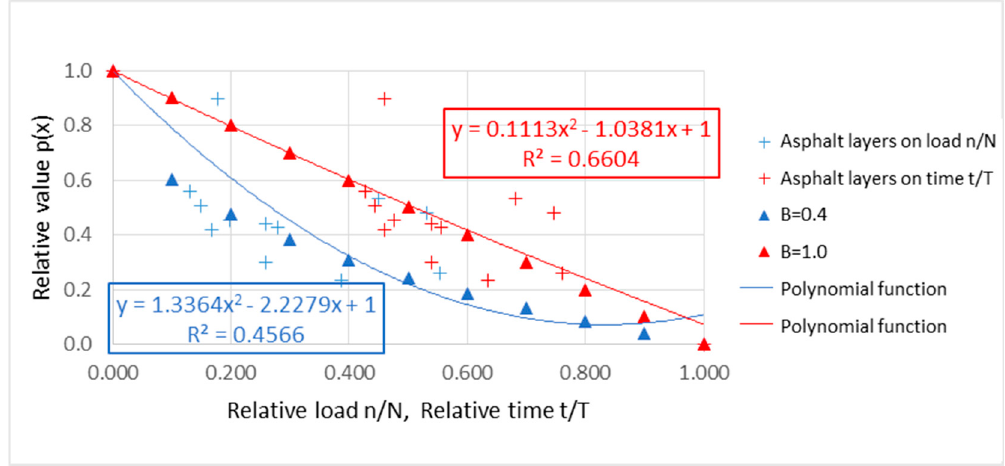
Figure 14. Degradation of the modulus of elasticity depending on the time t/T and load n/N (5.01–10.00 °C). 3.3.2. Road Foundation The modulus of elasticity of the base layers is not directly affected by the temperature influence during the measurement, as is in the case asphalt-bonded road construction lay-